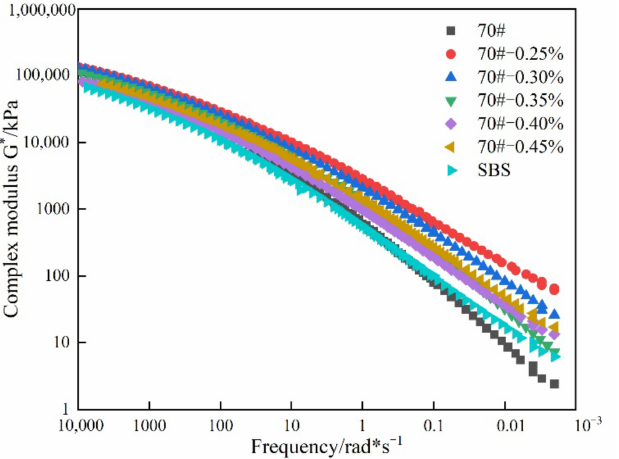
Figure 6. Master curves for the complex modulus of the asphalt